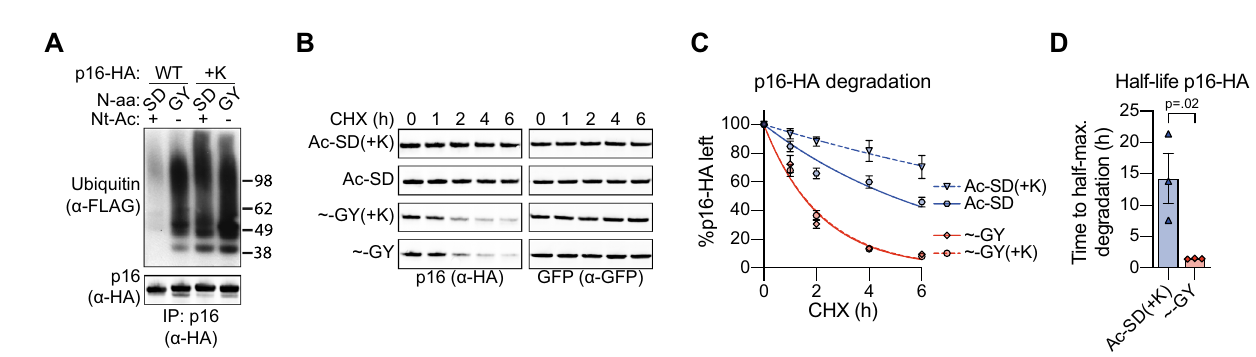
Figure 5. Introducing a lysine ubiquitin acceptor site does not affect p16 stabilization by Nt-acetylation. ( A ) HEK 293T cells were transfected to express indicated p16-HA variants in WT or + K versions and FLAG-tagged ubiquitin, followed by lysis under denaturing conditions. Next, p16-HA was immunoprecipitated and the precipitates were analyzed by immunoblotting. A representative image of three independent biological replicates is shown. ( B , C ) HEK 293T cells were transfected to express GFP as a reference protein, together with p16-HA variants carrying indicated N-terminal dipeptide sequences (”Ac-” = Nt-acetylated, “ ~ ” = Nt-acetyl-free). Cells were cultured in presence of CHX (50 μg/ml) for the indicated time periods, followed by immunoblot analysis with antibodies to the HA tag and to GFP. P16-HA signals were quantified and corrected for GFP signal intensity, and the resulting value at the 0 h time point was set to 100%. Data points were connected by a one-phase decay curve fit. Panel B shows a representative Western blot image, panel C shows the quantification. Note that the p16-HA (+ K) variants were studied in side-by side experiments with the p16 variants described in Fig. 4A, B. The Western blot and quantification for the ~ GY variant depicted in Fig. 4A, B are shown here again for comparison purposes (n = 3; mean ± SEM). ( D ) Based on the data in panel C, the half-lives of the indicated p16-HA variants were determined (n = 3; mean ± SEM; Ratio paired t-test,